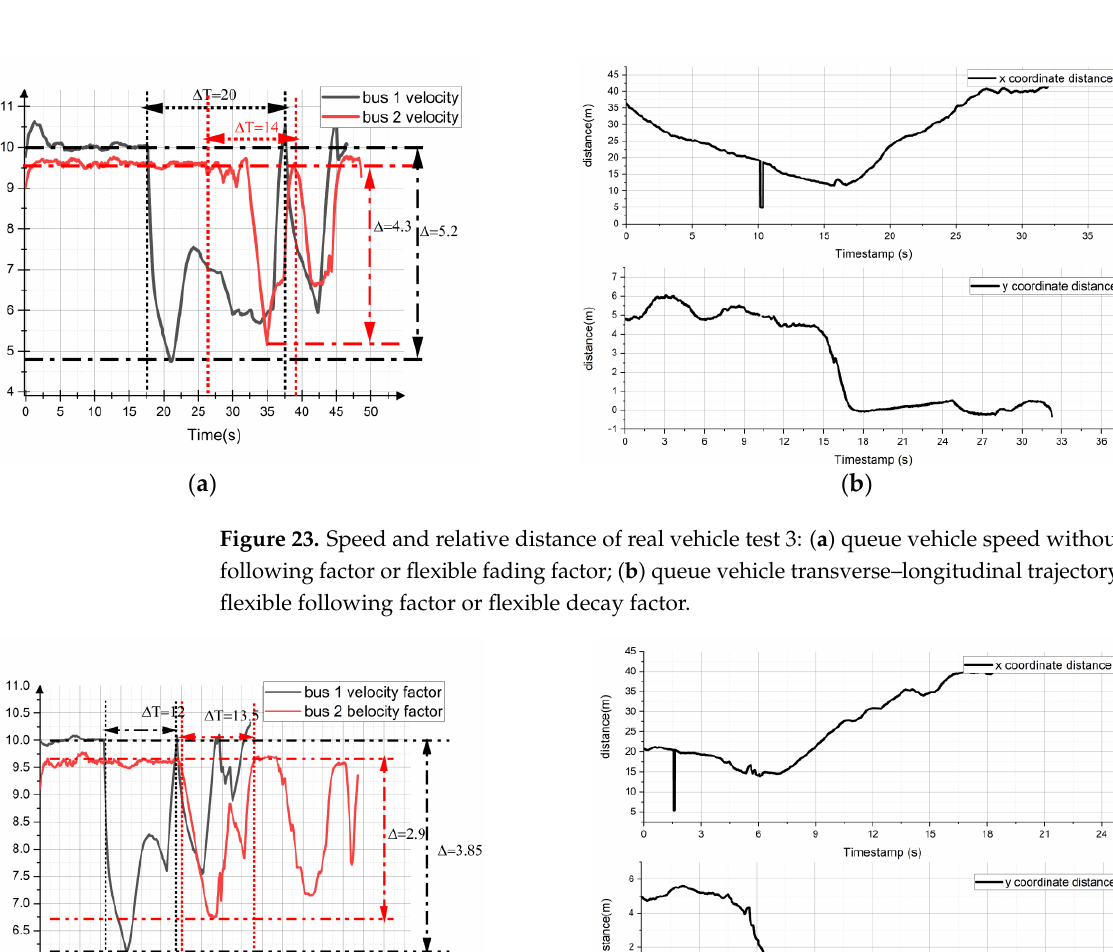
Figure 22. Speed and relative distance of real vehicle test 2: ( a ) queue vehicle speed with flexible following factor and flexible fading factor; ( b ) queue vehicle transverse – longitudinal trajectory with flexible following factor and flexible decay factor.